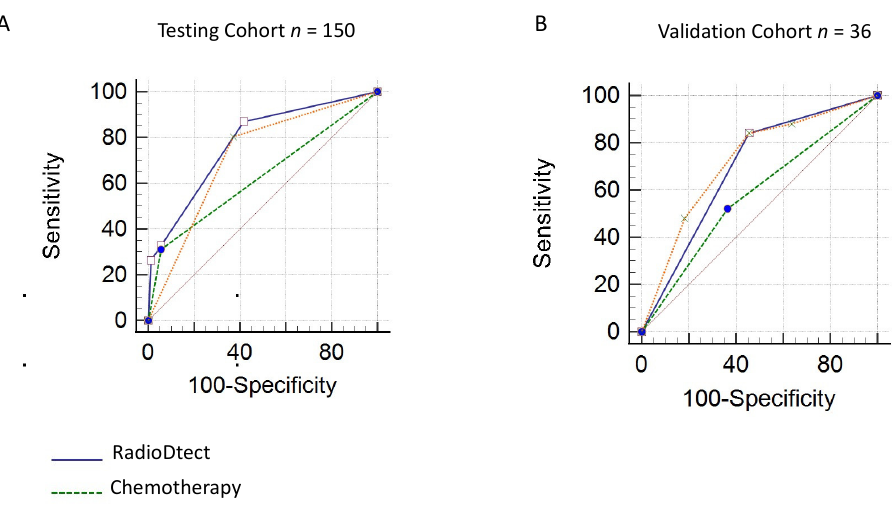
Figure 3. Performance analysis of combination of RadioDtect and chemotherapy as a binary variable for predicting grade ≥ 2 toxicities ( A ) ROC analysis for the testing cohort ( B ) ROC analysis for the validation